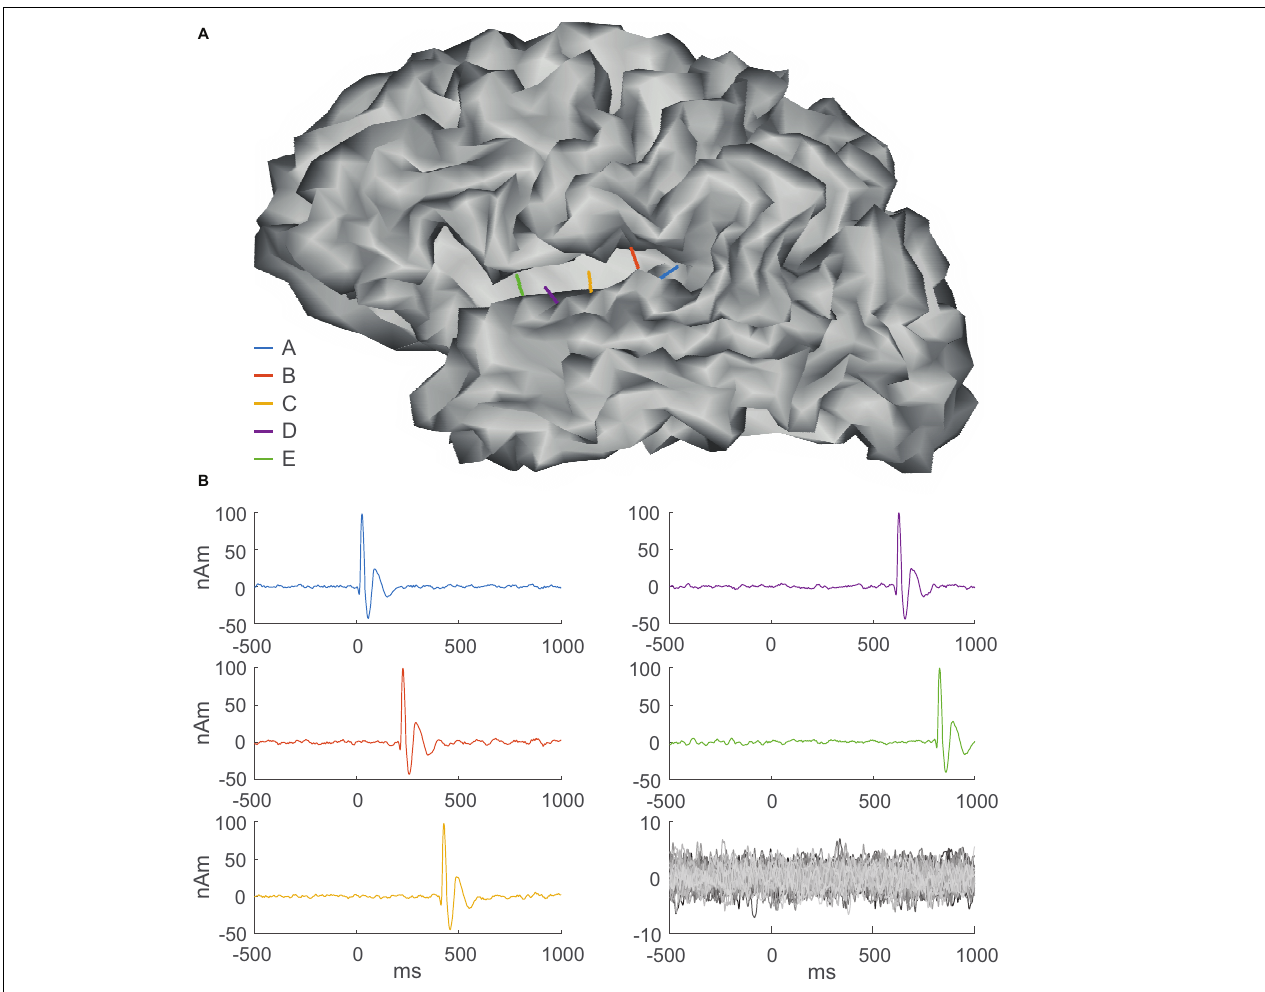
FIGURE 3 | Simulation setup. (A) Gray matter surface with five current dipoles in the superior temporal gyrus modeling epileptic foci, color-coded according to their sequential activation pattern as shown in (B) . (B) Time courses of sequentially activated dipoles (A–E) (color-coded graphs) modeling epileptiform discharges and background activity (lower right). One epoch comprises background activity lasting for 500 ms followed by a propagating epileptiform discharge lasting for 1